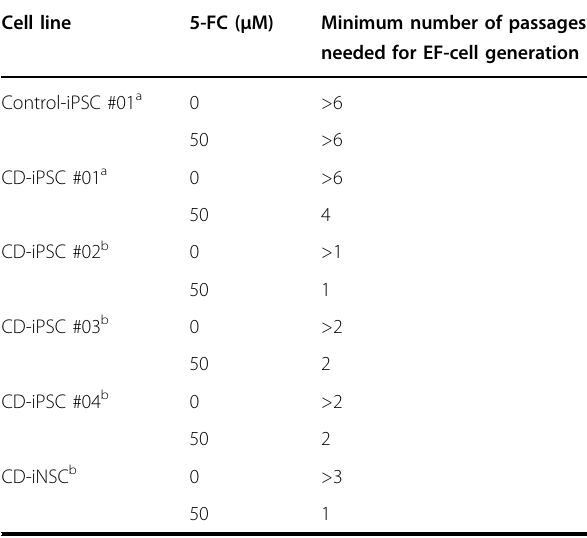
Table 1 Comparison of the effects of 5-FC treatment on the time required to eliminate the CD episomal vectors Cell line 5-FC ( μ